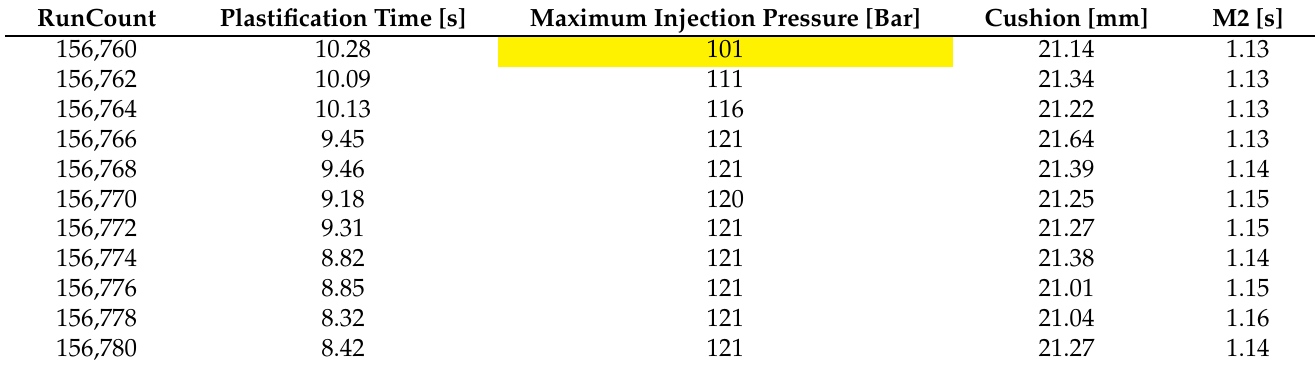
Table 2. Data with corresponding minimum or maximum values per feature.